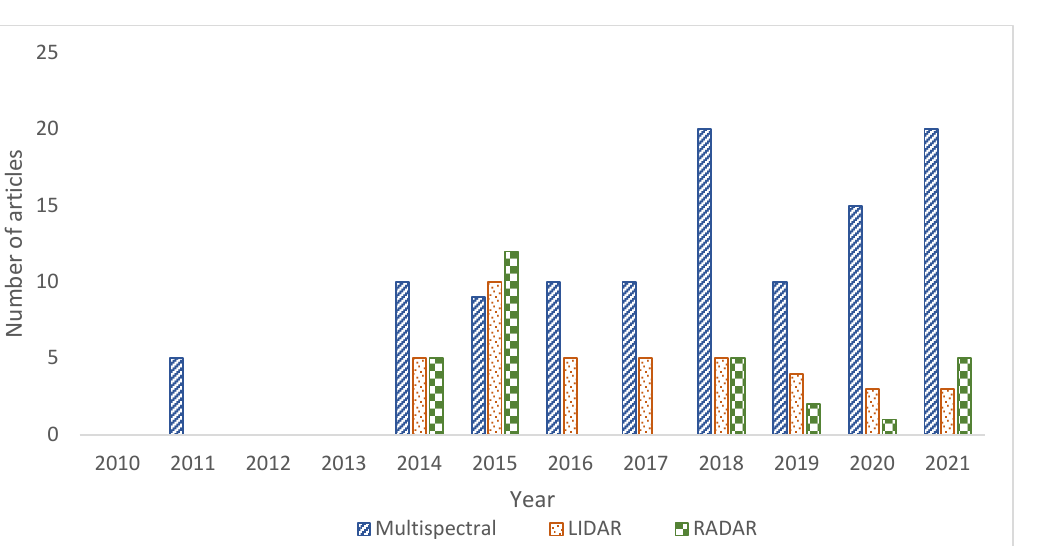
Figure 2. The Detailed Screening Process.